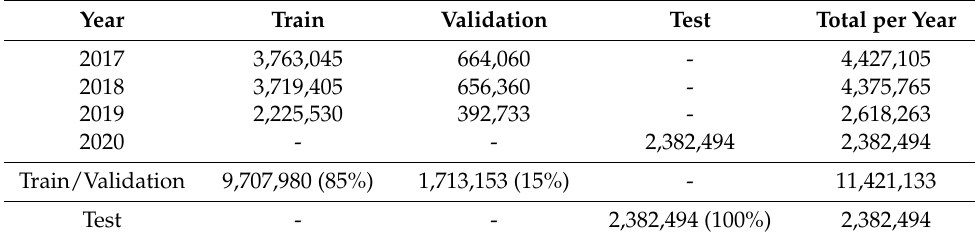
Figure 8. Distribution of training data considering the years 2017, 2018 and 2019. The axis of x-coordinates in base-10. Table 1. Distribution of datasets in training, validation and